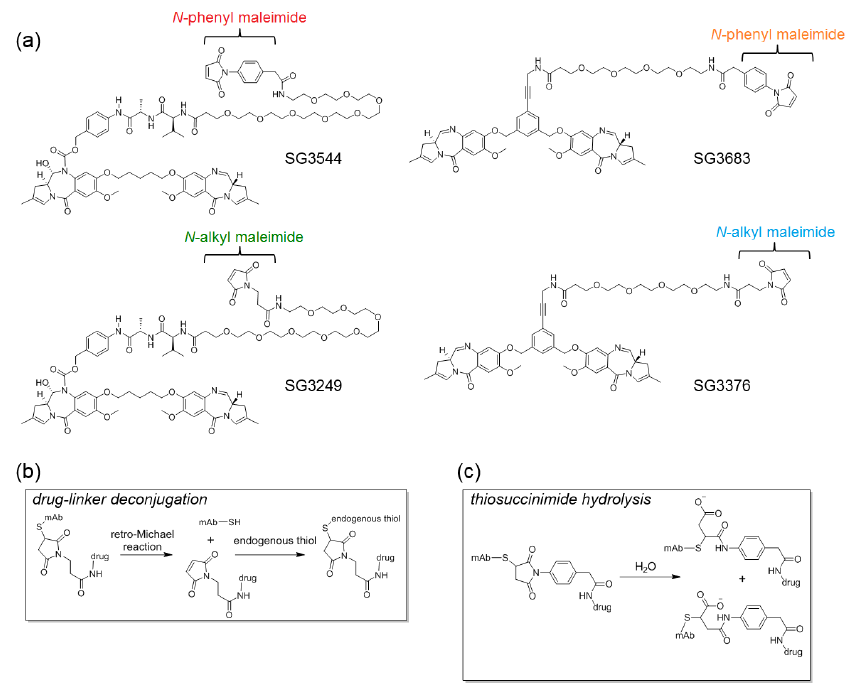
Figure 1. ( a ) Chemical structures of pyrrolobenzodiazepine (PBD) drug-linkers. Cleavable